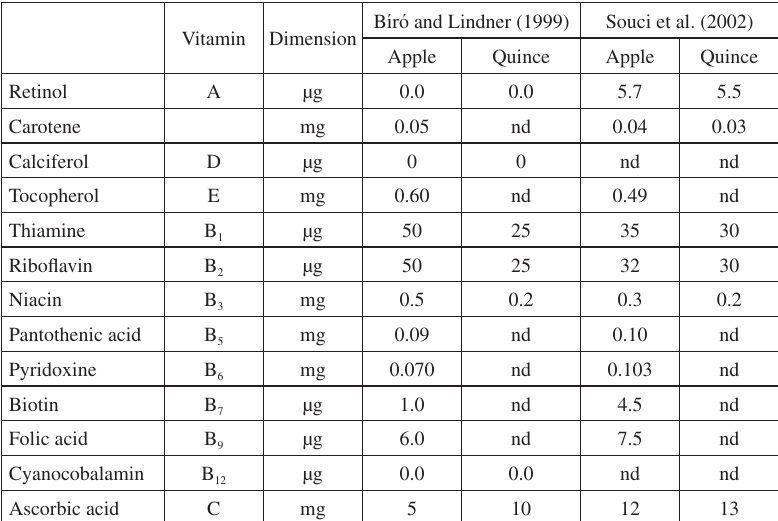
Table 2 . The vitamin contents in 100 g fresh quince and apple (‘Jonathan’) fruit according to Bíró and Lindner (1999) and Souci et al. (2002) Bíró and Lindner Vitamin Dimension